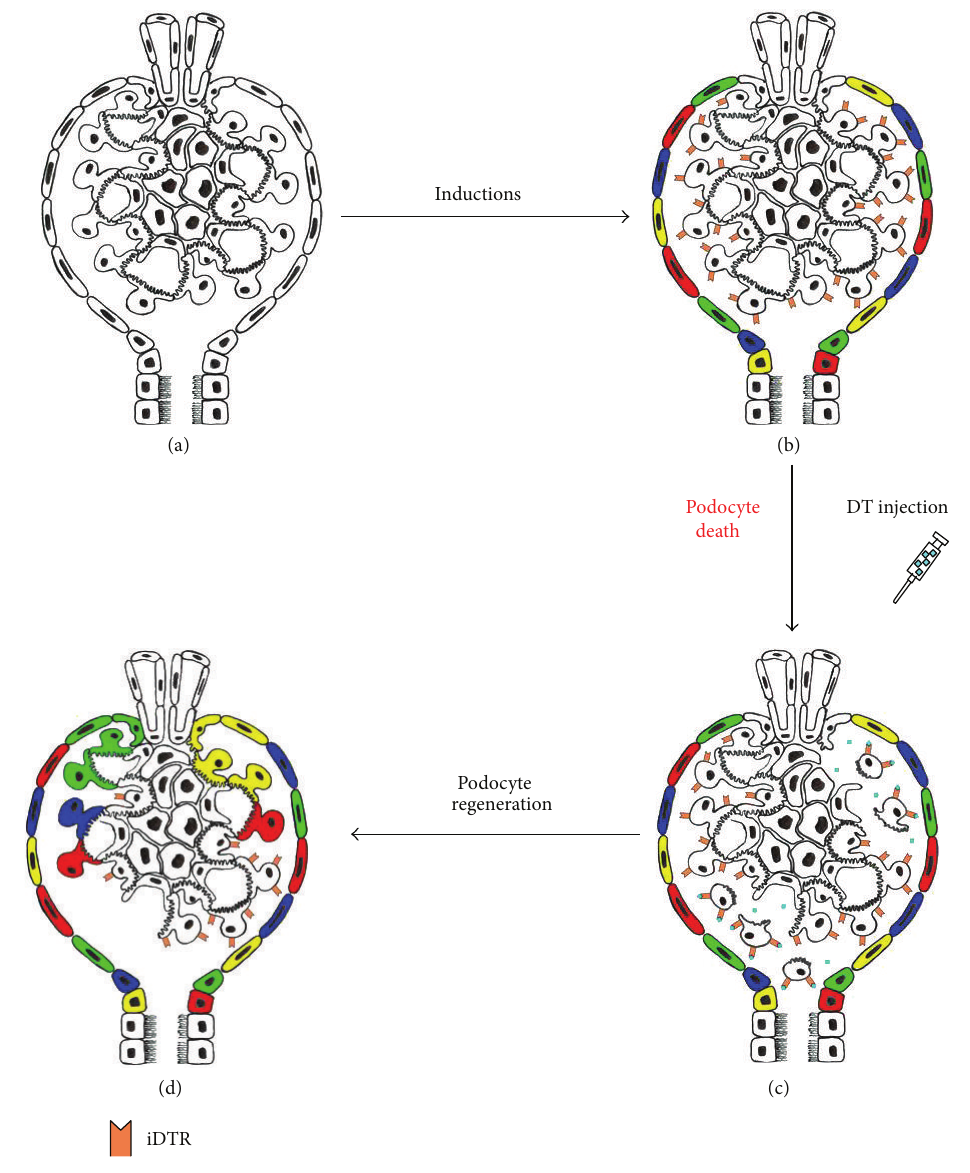
Figure 4: Hypothetical scheme of a combinatorial solution for PEC tagging and podocyte-specific ablation. (a) Glomerulus before induction of the two recombinatorial systems (Cre-LoxP and Flp-FRT), which can be induced independently and at different time points. (b) Once induced, the glomerulus would appear with Confetti-tagged PECs and iDTR-expressing podocytes. (c) At the prespecified time and dose, the operator could specifically ablate only podocytes. (d) De novo podocyte generation by the PEC compartment.